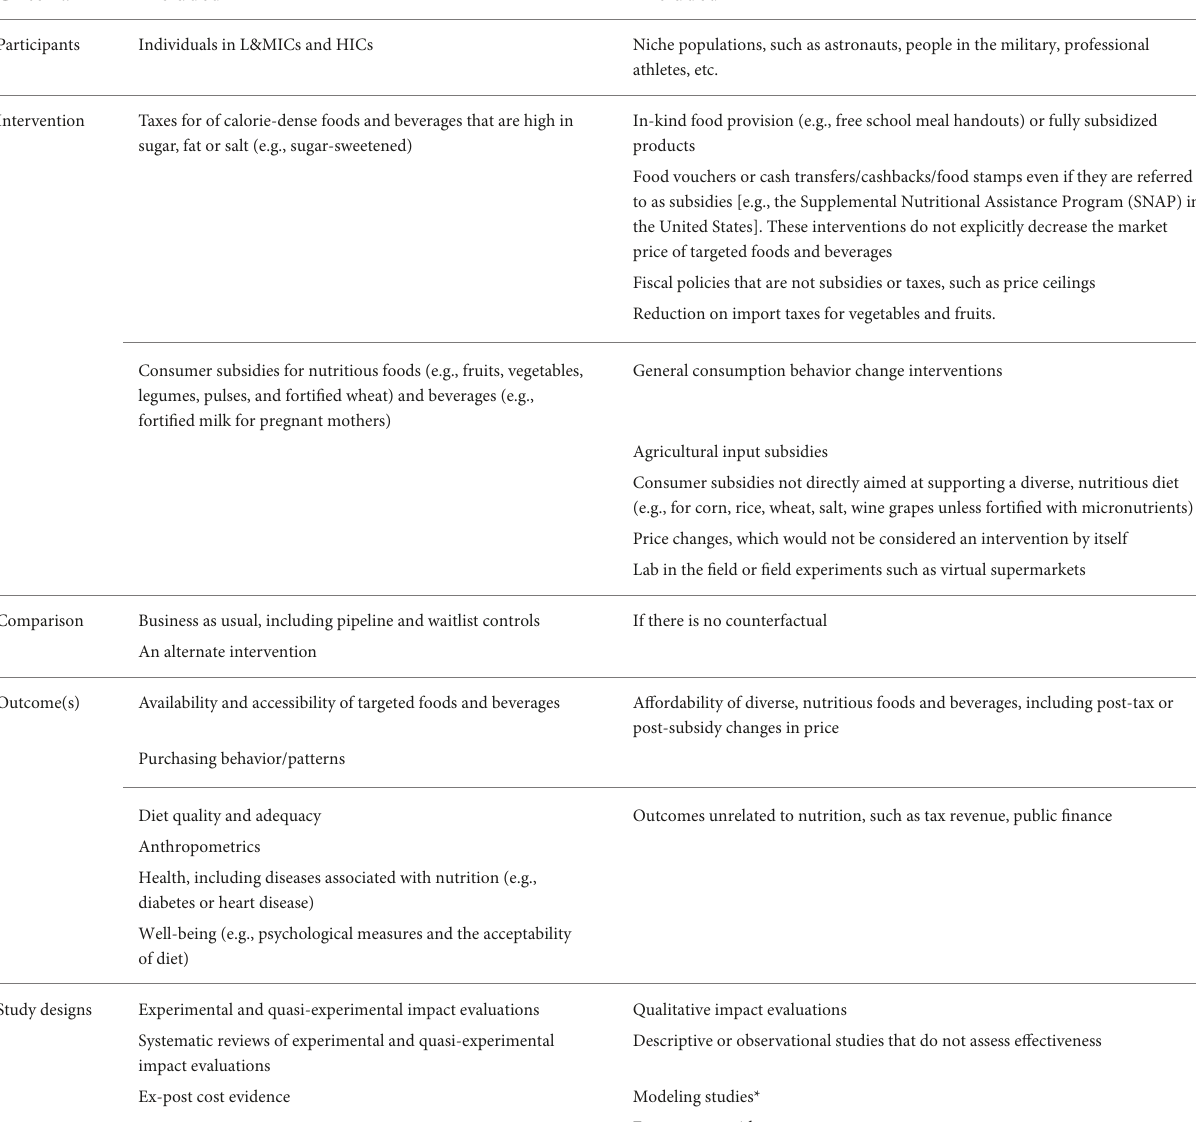
TABLE 1 Description of participations, intervention, comparison, outcomes, study designs. Criteria Included